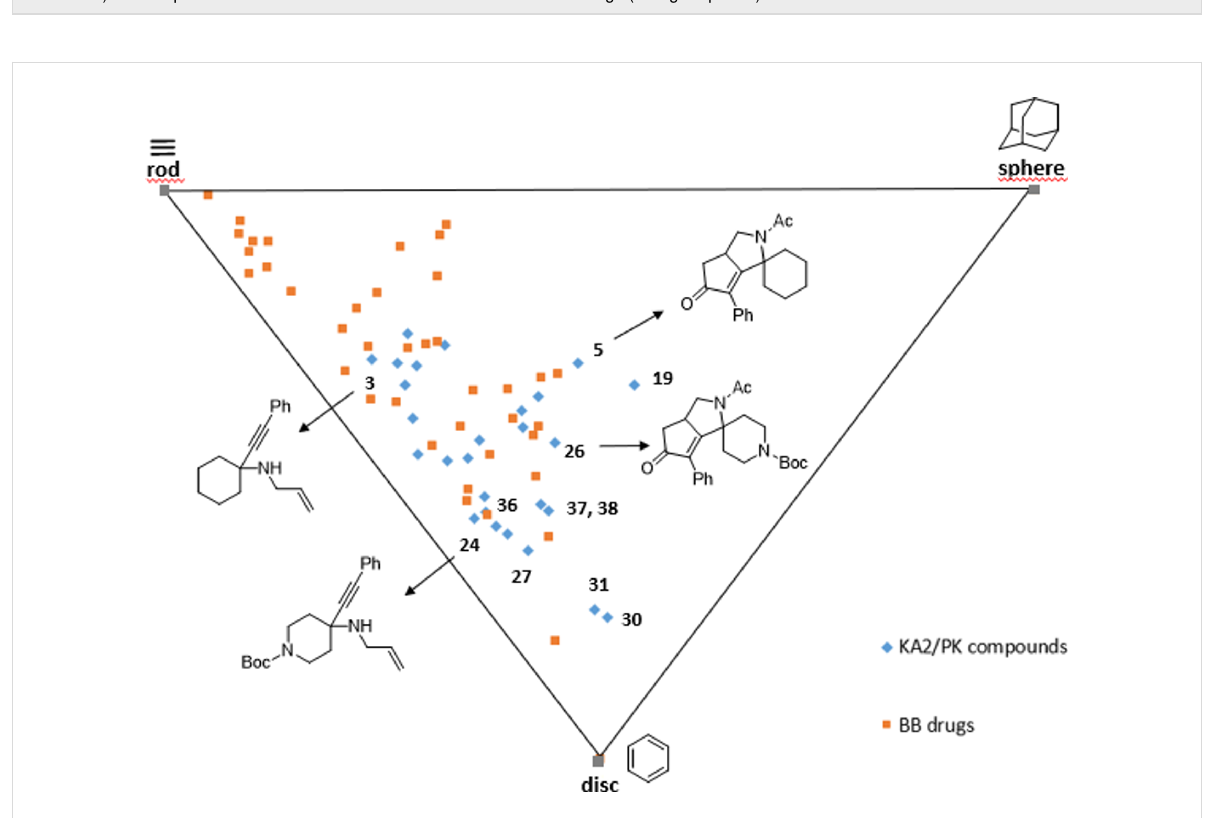
Figure 4: PMI plot showing the skeletal diversity of compounds 3 – 39 (blue diamonds) with respect to the reference set of brand-name blockbuster drugs (orange